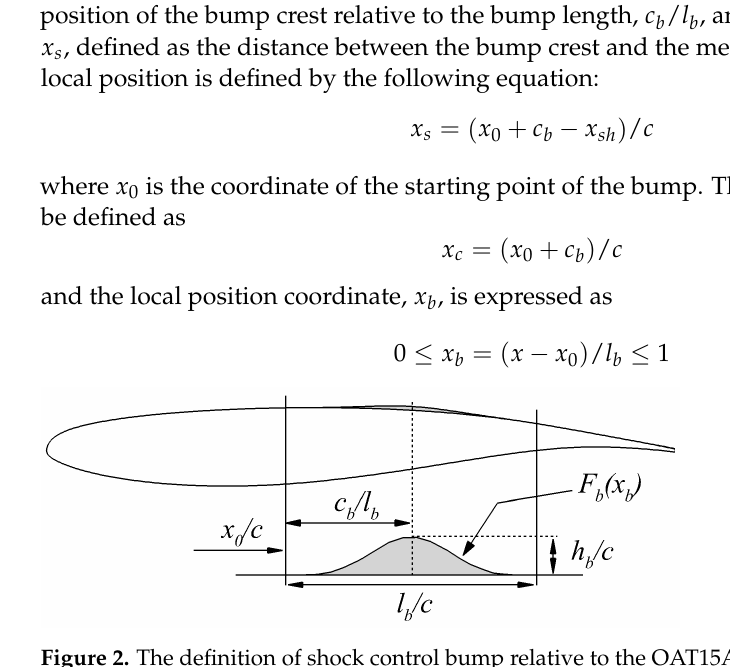
4 of 17 Figure 1. The definition of trailing-edge flap relative to the OAT15A airfoil.